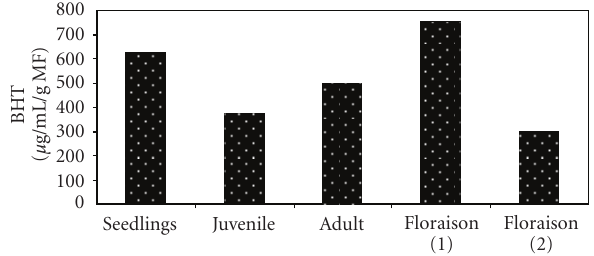
Figure 3: BHT content ( μ g/mL/g MF) in the plant leaves at di ff erent growth